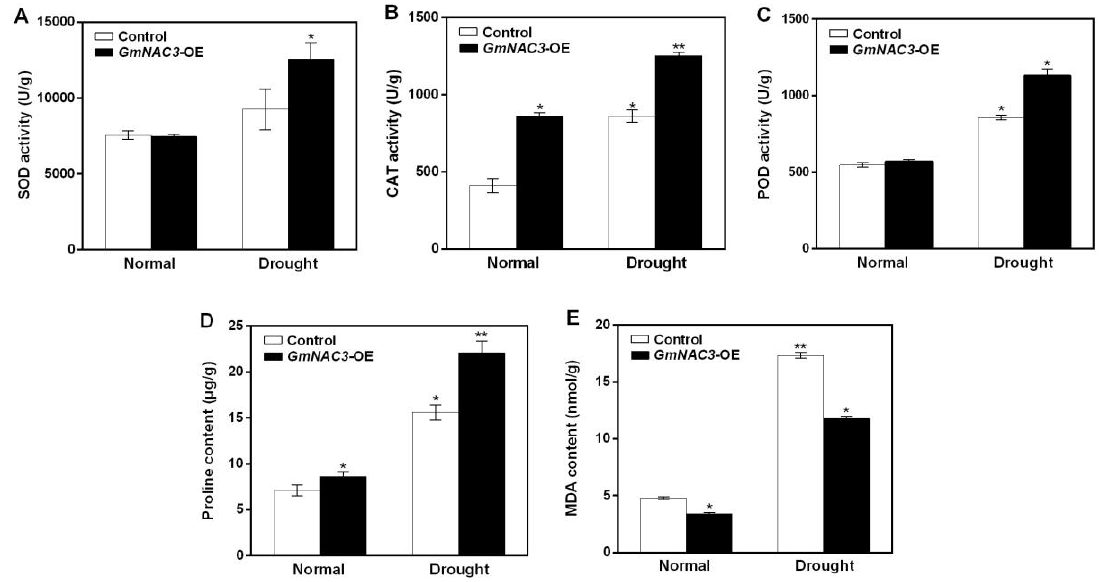
Figure 9. Physiological indices of soybean hairy roots under normal growth condition and drought stress for 12 h, including the enzymatic functions of superoxide dismutase (SOD) activity ( A ), catalase (CAT) activity ( B ), peroxidase (POD) activity ( C ), and the proline content ( D ) and malondialdehyde (MDA) content ( E ). Symbols “*” and “**” indicate significant differences at p values of 0.05 and 0.01, respectively.